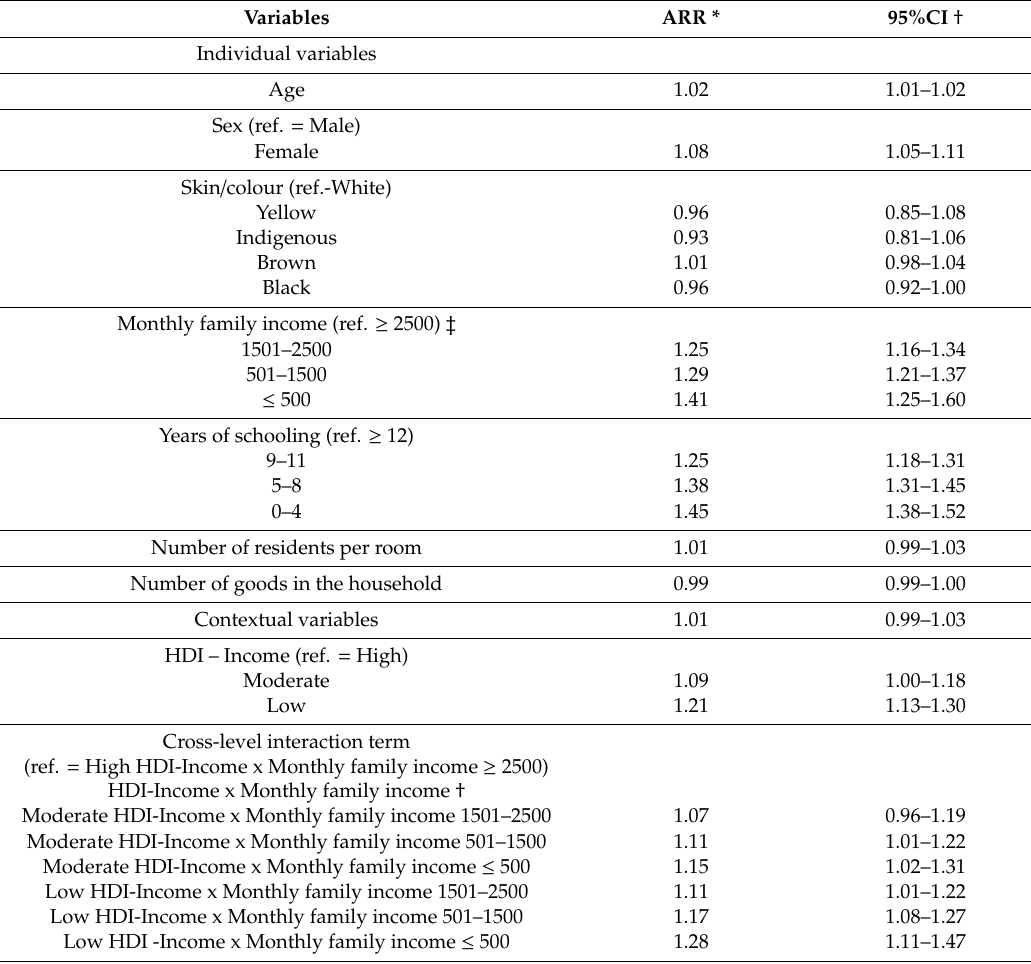
Table 3. Adjusted associations of HDI-Income (contextual factor) and individual characteristics with tooth loss among elderly people determined by multilevel negative binomial